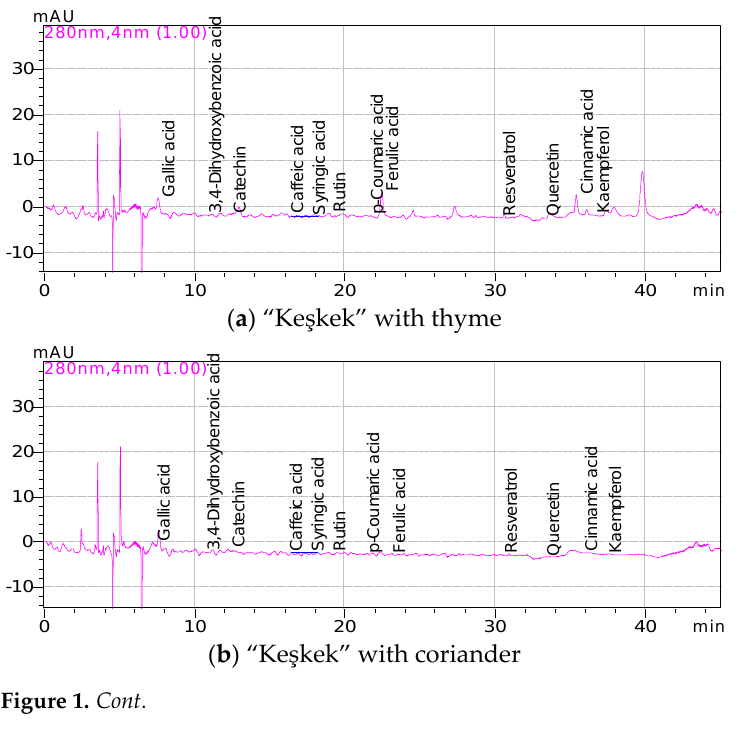
Table 2. Phenoli c compounds of “Keşkek” samples (mg/100 g).